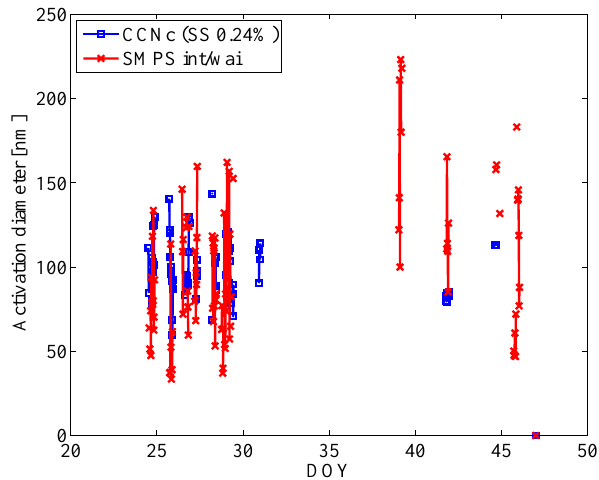
Fig. 14. Measured aerosol activation diameters during winter by CCN counter at SS 0.24% (blue squares) and by swithing between WAI and interstitial inlet using the SMPS (red